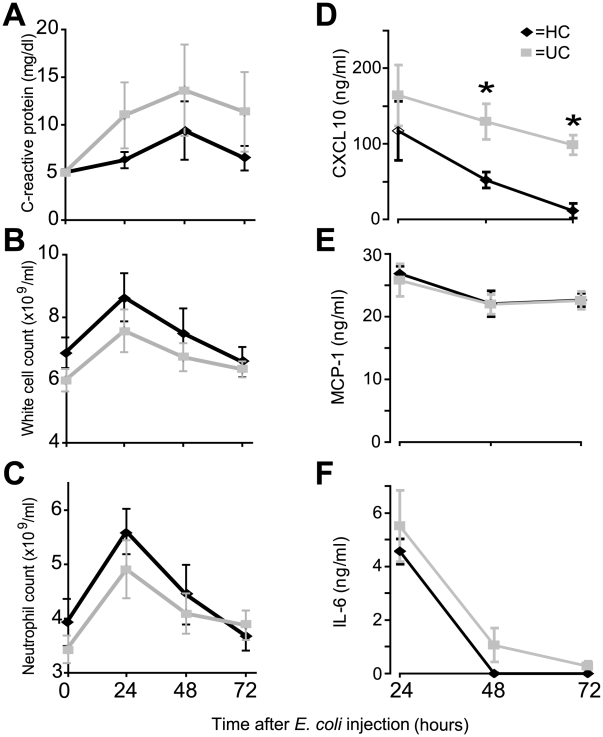
Systemic CXCL10 levels were elevated in UC patients.Effects of subcutaneous injection of HkEc on, (A) C-reactive protein (all subjects had baseline CRP levels of <5 mg/dl), (B) white cell count, (C) circulating neutrophil numbers, (D) CXCL10, (E) MCP and (F) -1 IL-6. TNF-α, IFN-γ, IL-8, IL-10, IL-13, IL-17 and MIP-1α were undetectable in serum samples at all time-points. Results are expressed as a mean ± SEM (*p<0.05).